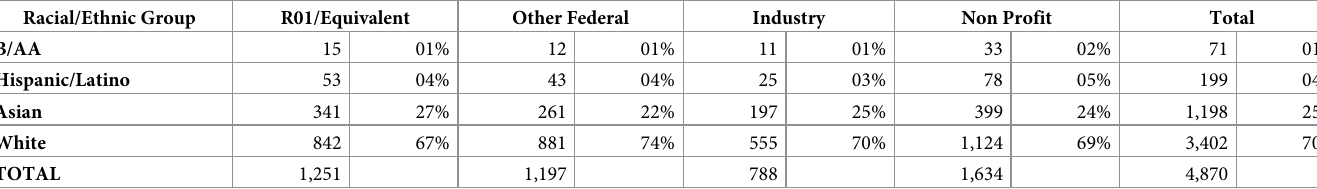
Table 3. Number of UMMS awards by racial/ethnic group and submission category